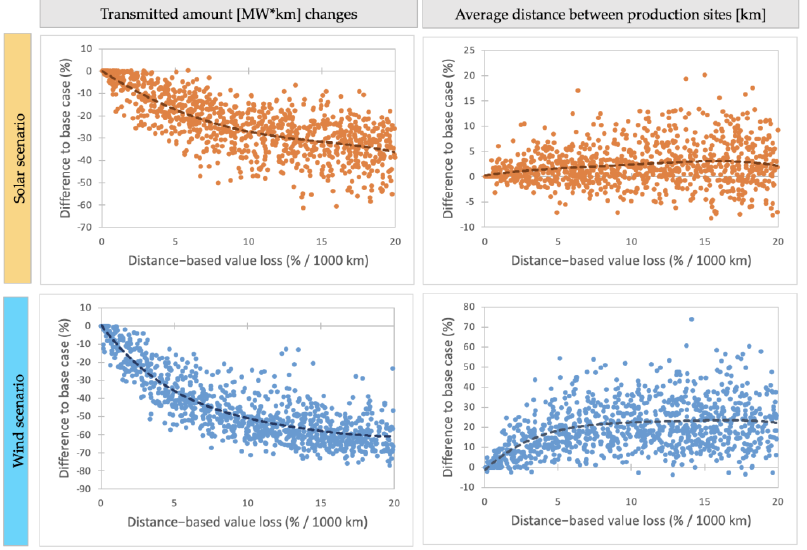
Figure 5. Results of the transmitted power and production positioning for the wind and solar scenarios.